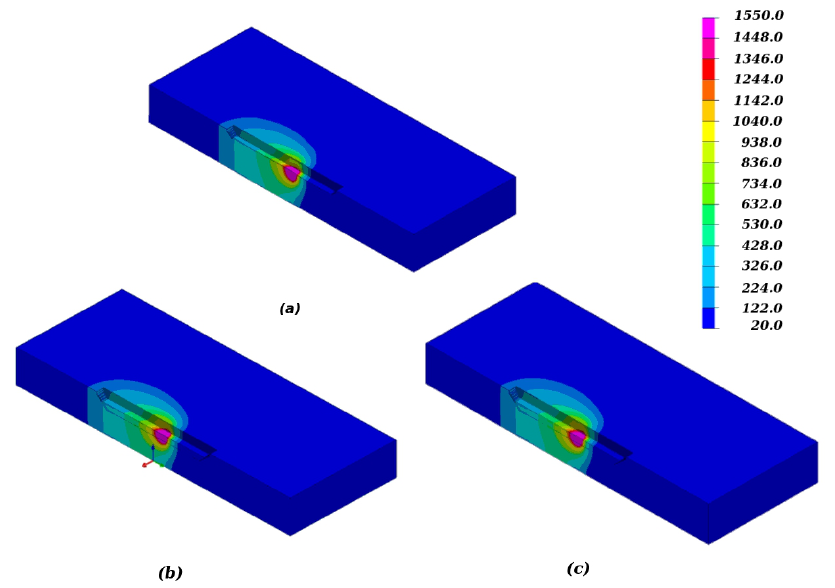
Figure 6. Temperature distributions calculated at t = 34s with ( a ) mesh A, ( b ) mesh B, ( c ) mesh